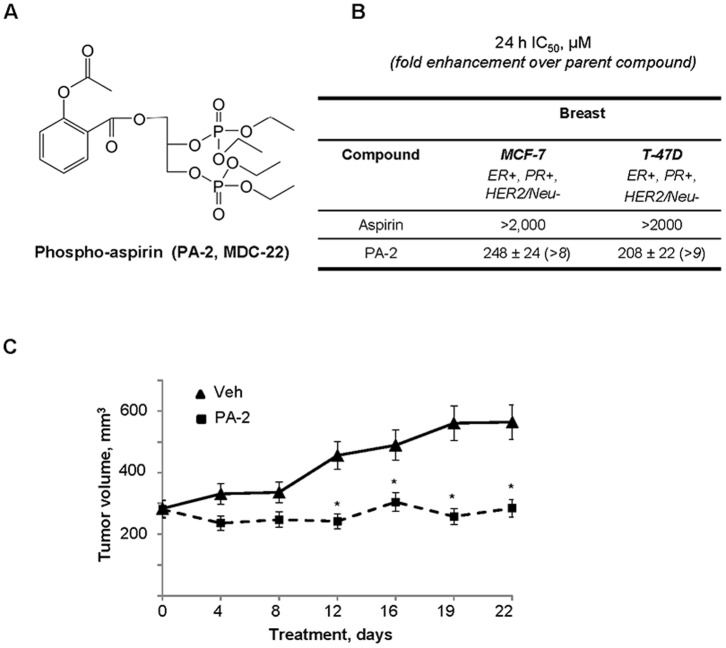
Phospho-aspirin-2 inhibits the growth of ER+ breast cancer cells.A: Chemical structure of phospho-aspirin-2 (PA-2, MDC-22). B: 24 h-IC50 values of PA-2 and aspirin in ER+ breast cancer cell lines. C: Chemotherapeutic effect of PA-2 on subcutaneous MCF7 xenografts in nude mice. Nude mice bearing established MCF7 xenografts were treated with vehicle or PA-2 (500 mg/kg in corn oil) for five times a week. *, p<0.01, compared to control; n = 16 tumors/group.